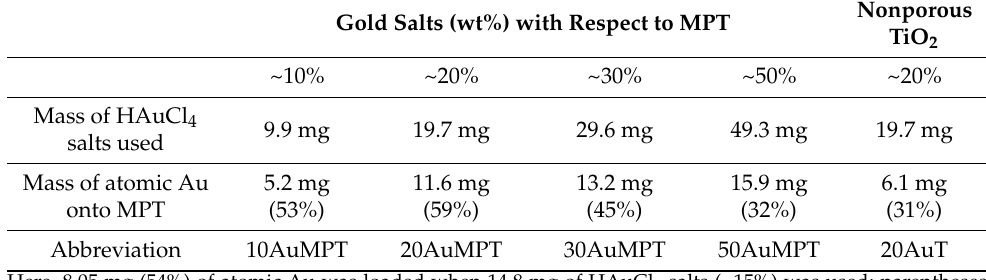
Table 1. Preparation of composite particles as a function of the amount of gold salts.